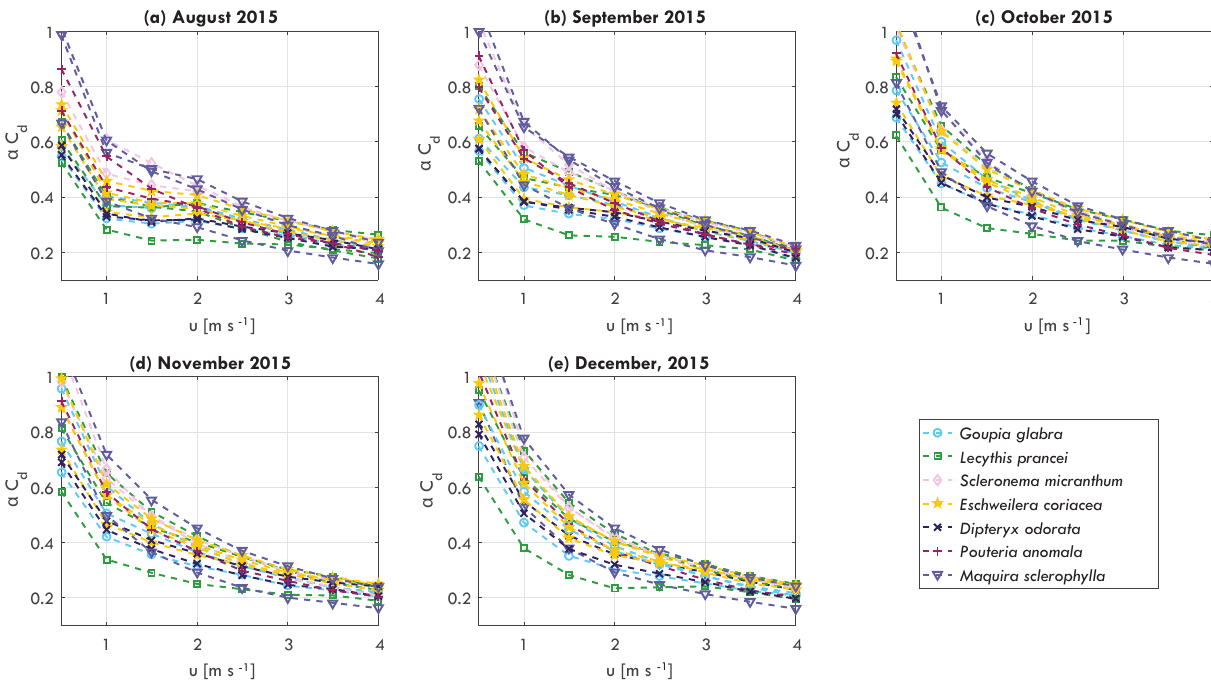
Figure 4. Monthly averaged tree–atmosphere momentum transfer αC d per individual tree as a function of wind speed u [ms − 1 ] for (a) Au-